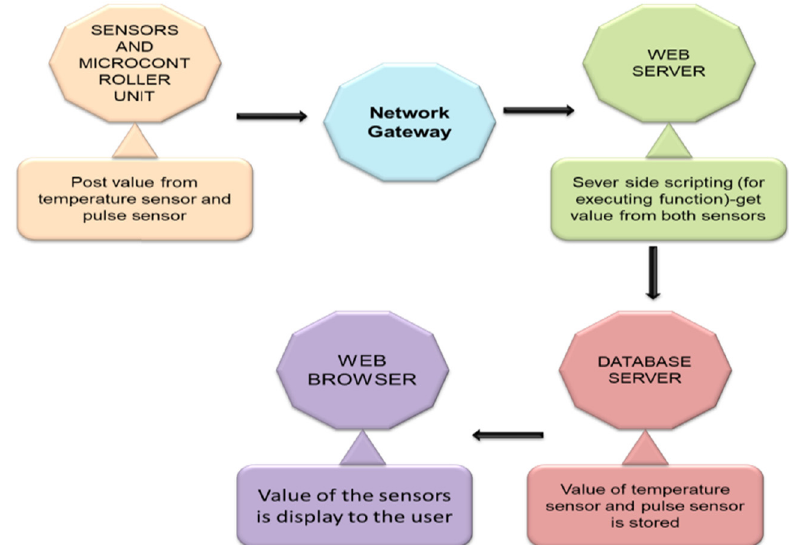
Figure 2: Framework of